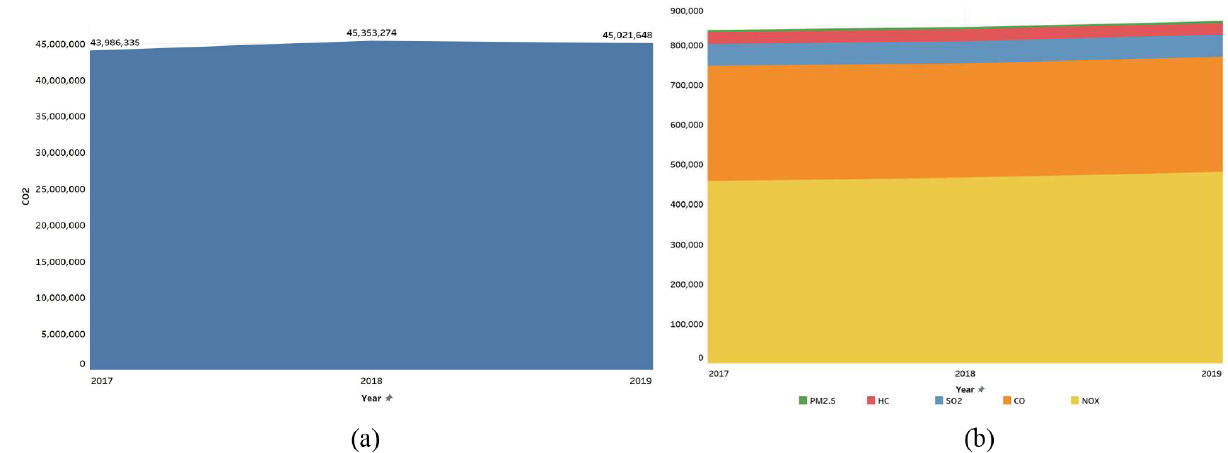
Figure 5. Annual overall emissions of six pollutants after the CNG2020 strategy was proposed (tonnes). (a) Annual overall emissions of CO 2 from 2017 to 2019. (b) Annual overall emissions of the other five pollutants from 2017 to